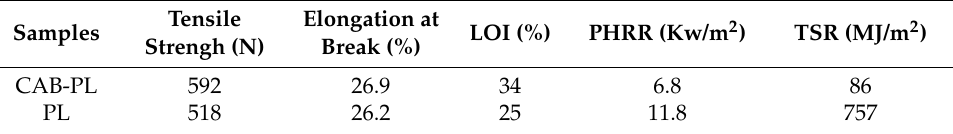
Figure 1. Tensile strength–elongation curves of the ( a ) polyester fabric coated with calcium alginate /nano-calcium borate composites (CAB-PL) and ( b ) polyester fabric (PL). Table 1. Mechanical properties and combustion behavior of the CAB-PL and PL.